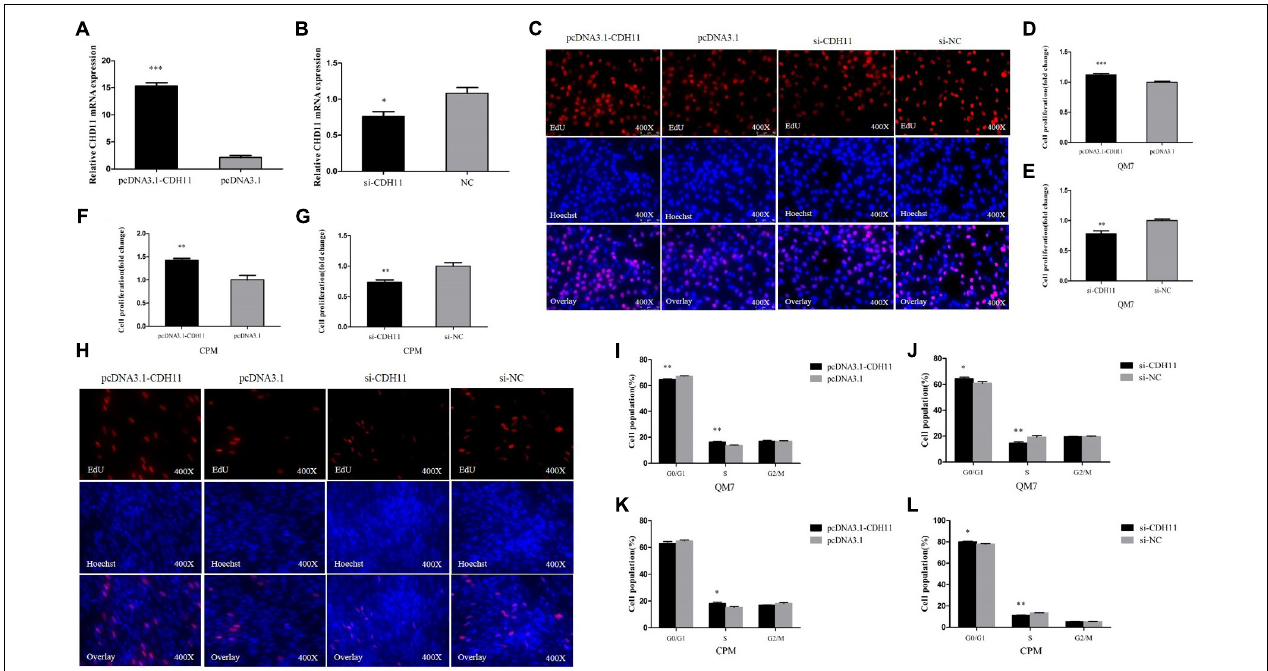
FIGURE 1 | CDH11 facilitates the proliferation of myoblast. (A,B) The mRNA level of CDH11 after CDH11 overexpression and knockdown in CPM cells. (C,H) EdU proliferation assays for QM7 and CPM cells with overexpression and inhibition of CDH11. (D–G) The number of proliferative cells was also counted. (I–L) QM7 and CPM cells were collected for cell cycle analysis 48 h after transfection. Results are shown as mean ± SEM and the data are representative of at least three independent assays. Independent sample t -test was used to analyze the statistical differences between groups. ∗ P < 0.05; ∗∗ P < 0.01; ∗∗∗ P <